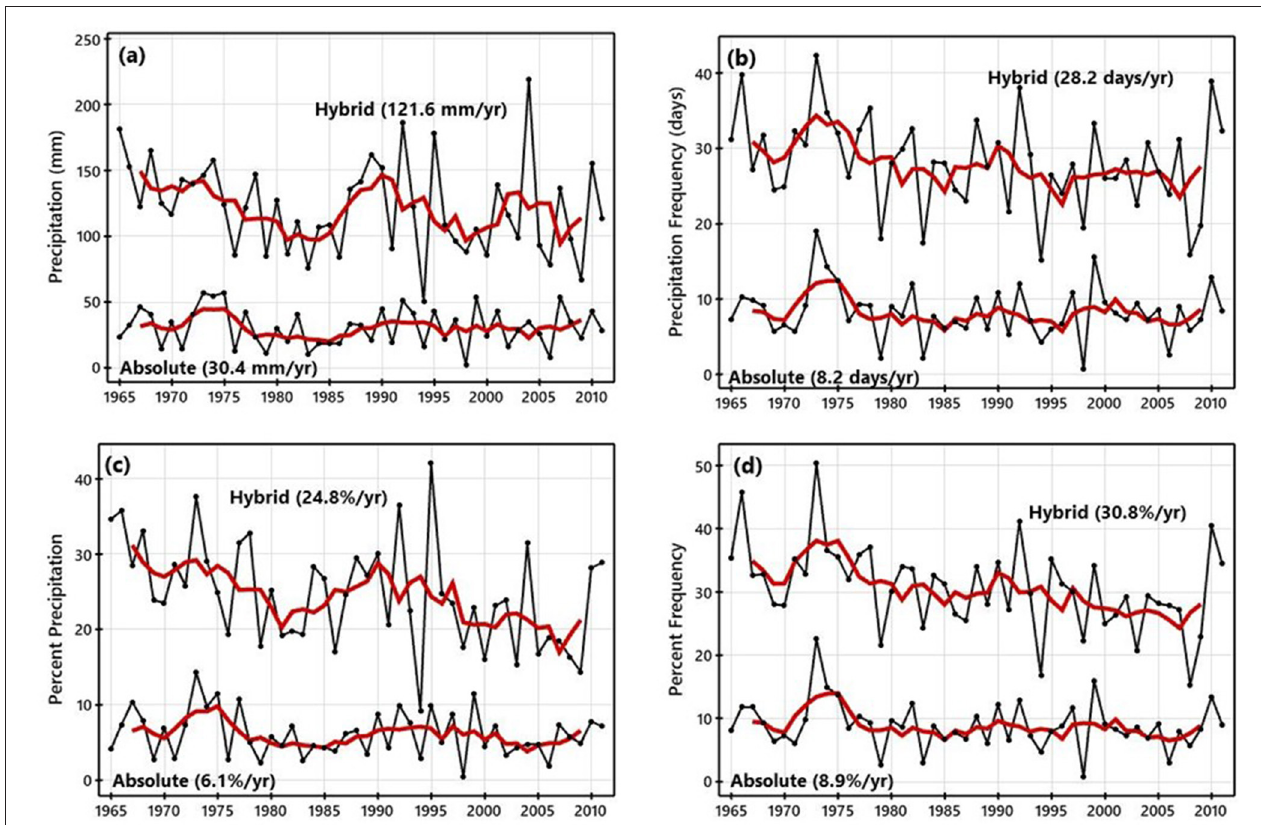
FIGURE 8 | For the 45 precipitation stations (Figure 7) , regional mean seasonal values of precipitation (a) , precipitation frequency (b) , percent of seasonal precipitation (c) , and percent of seasonal precipitation frequency (d) attributed to days within the hybrid and pure data sets for the period 1968–69 through